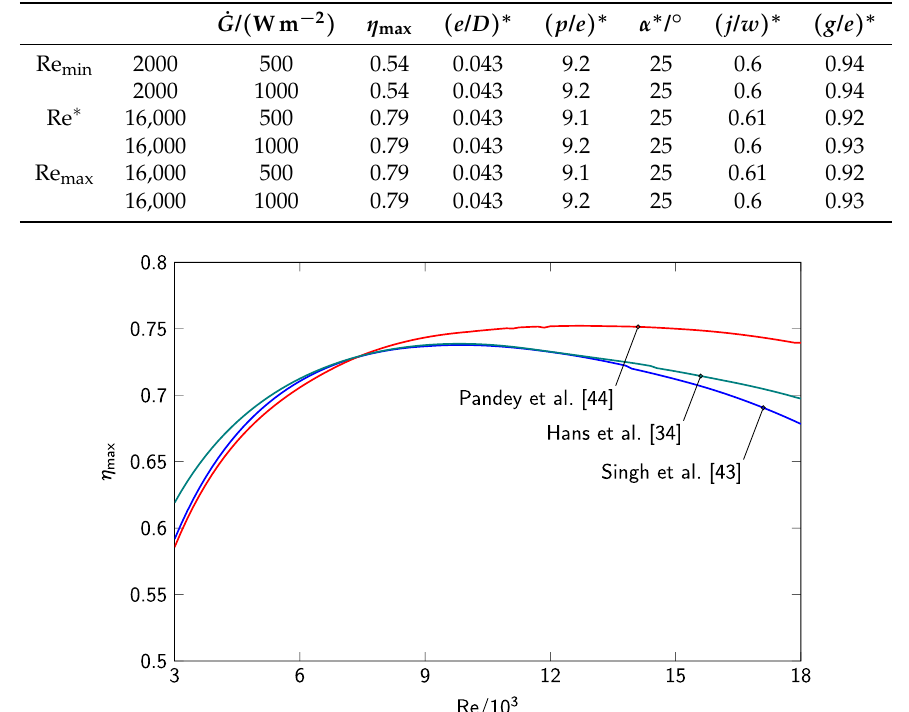
Table 8. Maximum efficiency and optimum roughness parameters according to the model developed by Hans et al. [34].